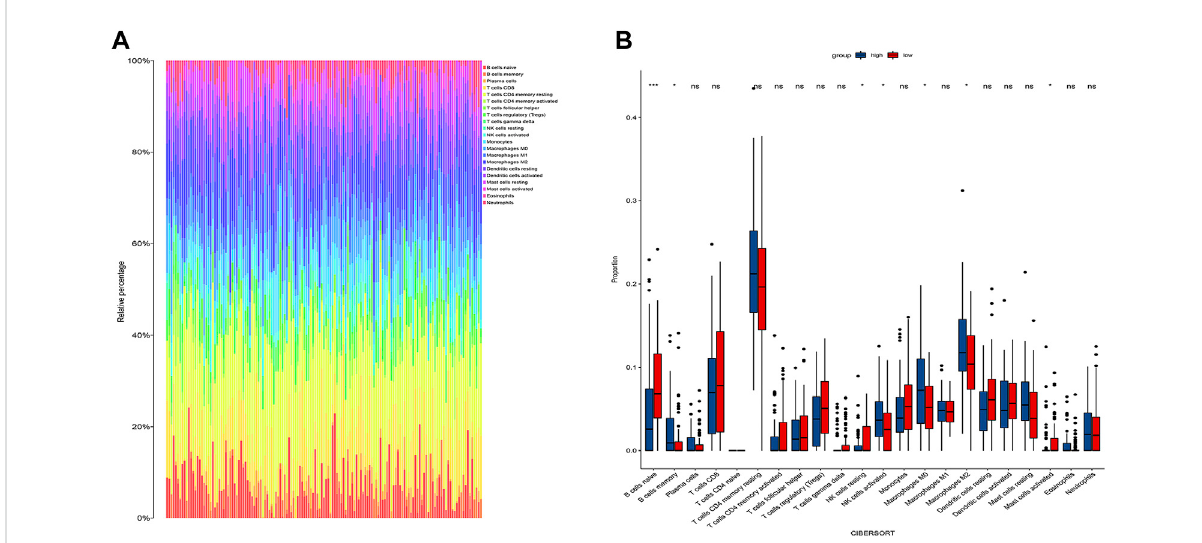
FIGURE 7 Immune in fi ltration analysis. (A) The proportion of different immune cells in tumors. (B) Differences in immune cells between high and low-risk groups. We found differences in B cells, NK cells, and Macrophages between high and low-risk groups. We then performed a LASSO regression analysis and T cells regulatory Tregs, Macrophages.M2, Mast.cells.activated, and Eosinophils were screened out. We retained